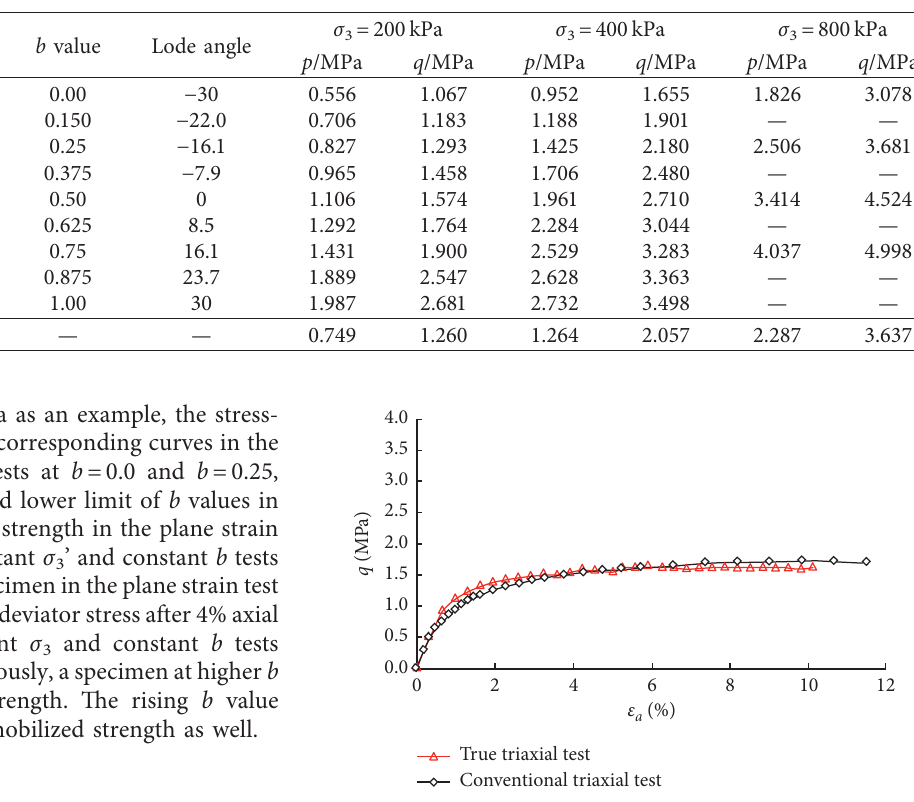
Table 2: Test program and corresponding peak states.